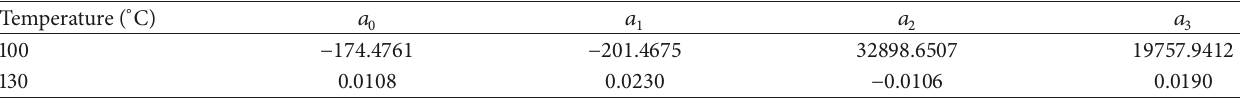
Table 8: The values of 𝑎 0 , 𝑎 1 , 𝑎 2 , and 𝑎 3 in the SL 50 prediction model calculated at 100 ∘ C and 130 ∘ C by Farhoosh and Hoseini-Yazdi (2013).